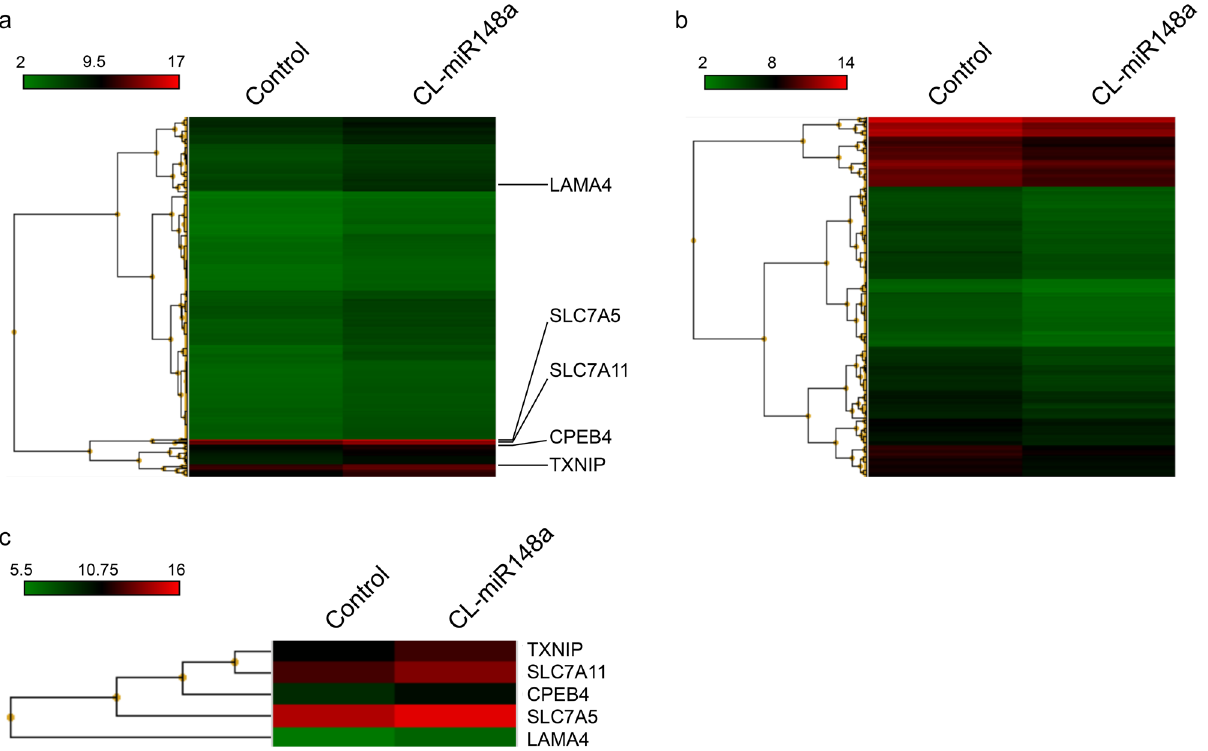
Figure 4. Heatmaps of the differential expression of mRNAs in no AMO (control) or CL-miR148a-transfected MCF-7 cells. High expression levels are in red, and low expression levels are in green. Compared with the control, 461 genes were upregulated by CL-miR148a transfection ( a ), whereas 462 genes were downregulated ( b ). After performing an online database analysis, five candidate genes were selected. The five candidate genes